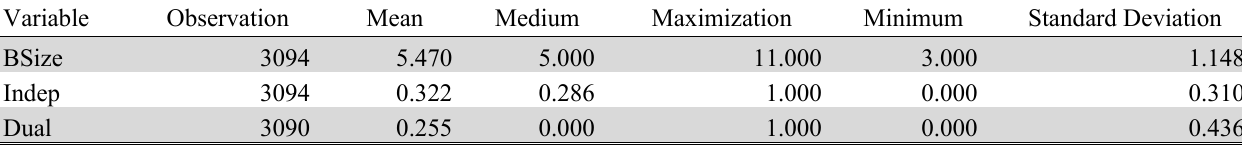
Descriptive statistics of board composition